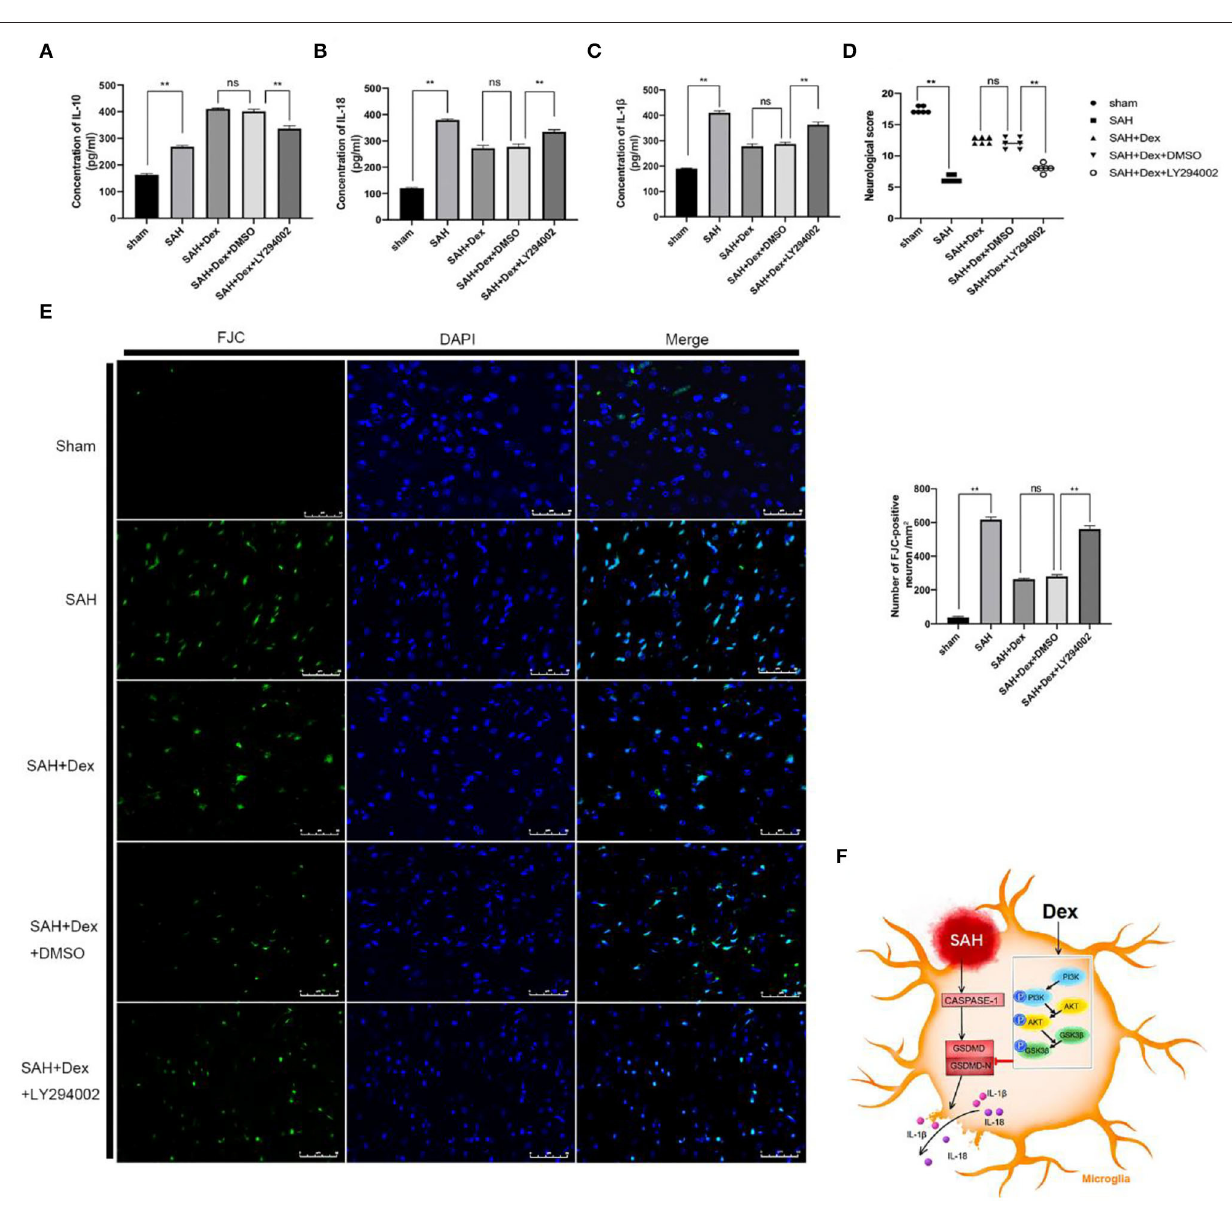
FIGURE 9 | LY294002 abolished Dex effects on inflammatory cytokines production, neurobehavioral deficits, and neuronal injury after 24h SAH. (A–C) ELISA results indicating the levels of the pro-inflammatory factors IL-1 β , and IL-18 and the anti-inflammatory factor IL-10 in the ipsilateral cerebral tissue; n = 6 in each group. (D) Modified Garcia scores for each group; n = 6 in each group. (E) Representative FJC and DAPI staining images and quantitative analysis of FJC-positive cells in the ipsilateral cerebral cortex; n = 6 in each group. Data are expressed as the mean ± SD. ** P < 0.01. Scale bar = 50 µ m. (F) Graphical abstract of how Dex alleviates GSDMD-induced microglia pyroptosis after SAH via PI3K/AKT/GSK3 β pathway.